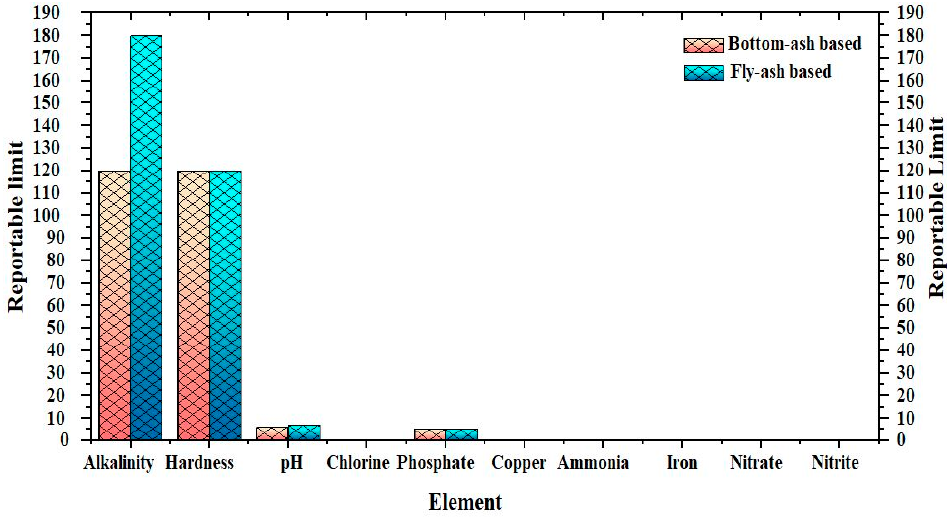
Figure 8. Leaching range of GPCs over 300 freeze-thaw cycles.